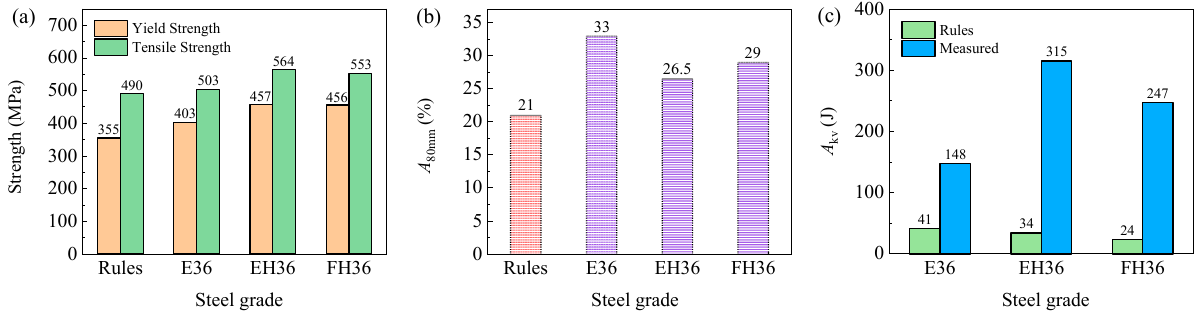
Figure 7. Strength ( a ), elongation ( b ), and impact toughness ( c ) indexes of the three grades of steel plate.